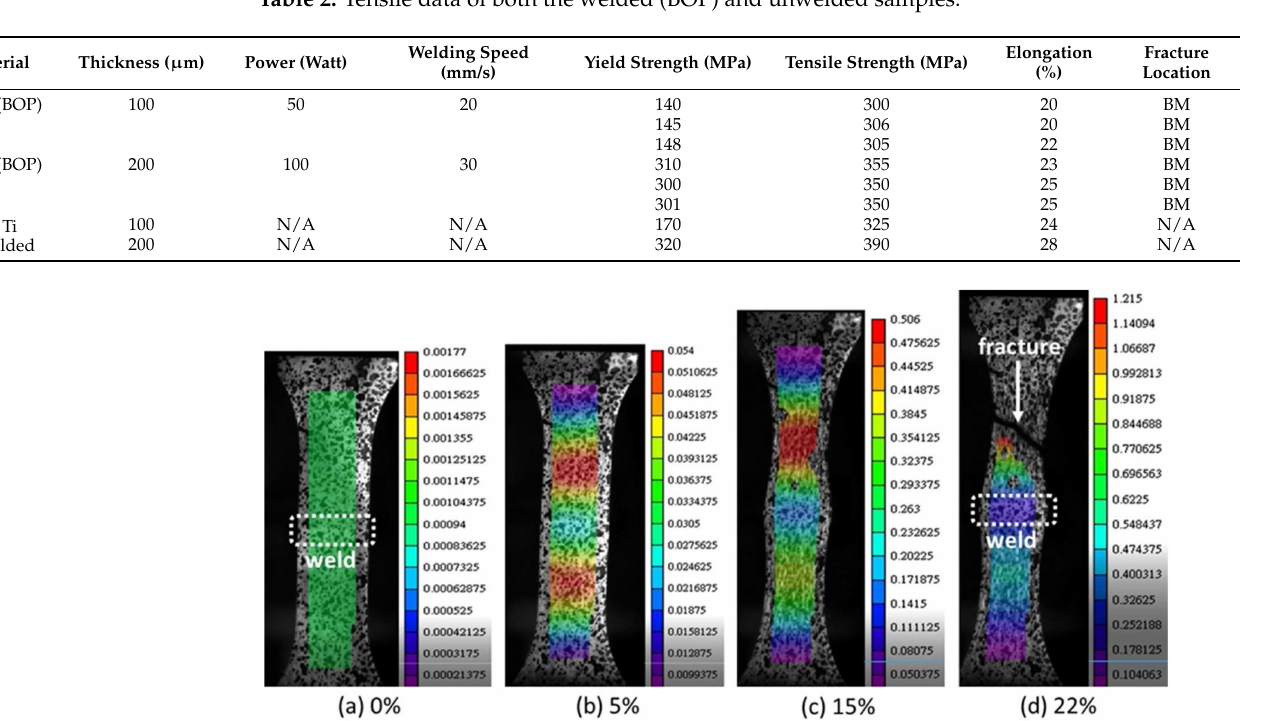
Table 2. Tensile data of both the welded (BOP) and unwelded samples.